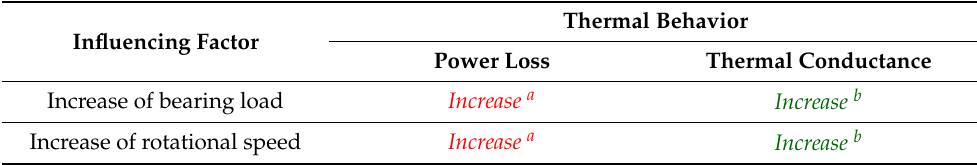
Table 4. Effect of main operating conditions on thermal properties of the bearing system.